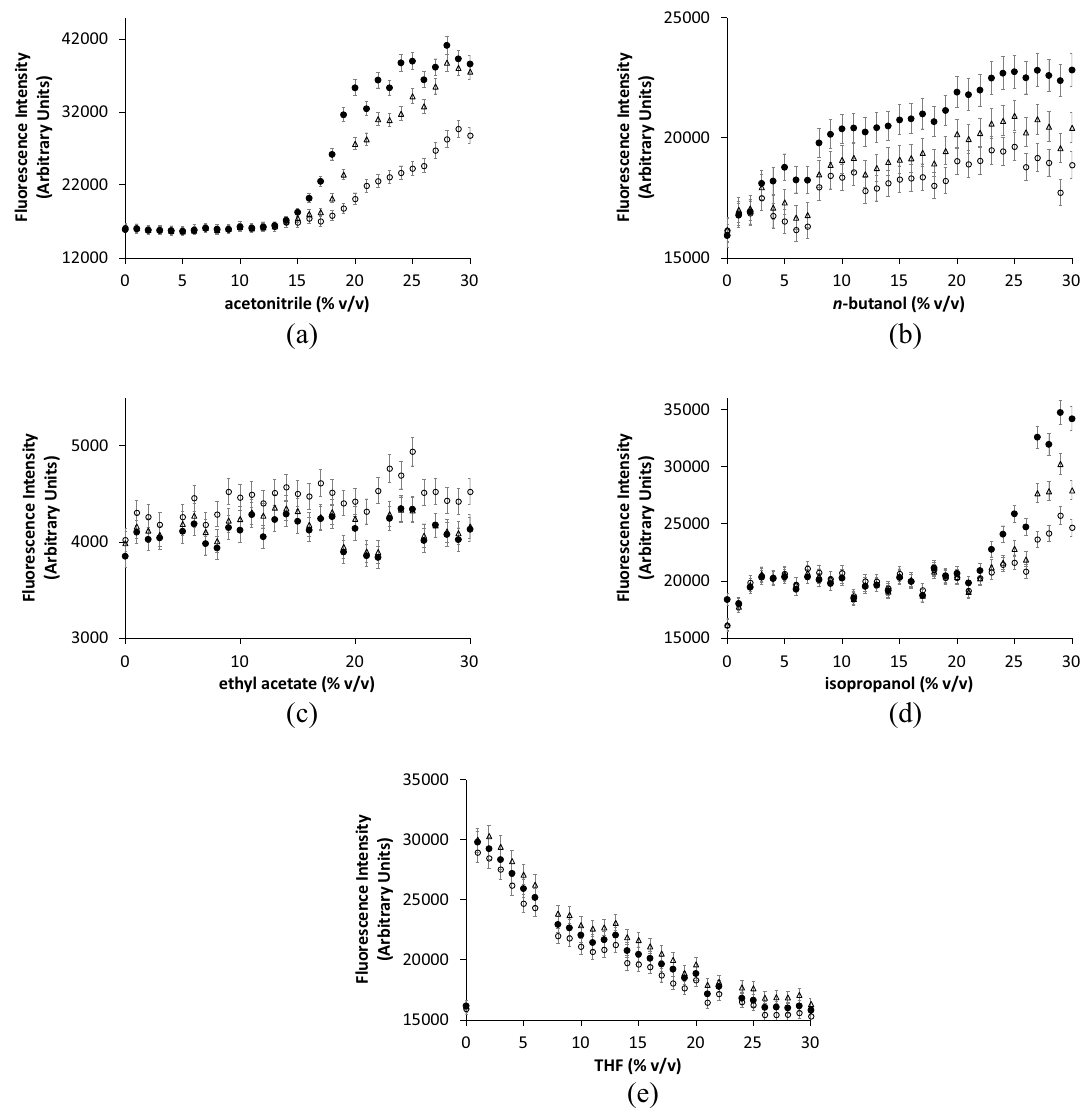
Figure 8. Fluorescence intensity measurements of apo-TK after incubation with increasing concentrations of organic solvents. Fluorescence intensity was measured at 340 nm with excitation at 280 nm. Apo-TK at 0.1 mg mL −1 in 25 mM Tris–HCl, pH 7.0 was incubated with ( a ) acetonitrile ( b ) n-butanol, ( c ) ethyl acetate ( d ) isopropanol ( e ) THF for (open circle) 1 h, (open triangle) 2 h, (filled circle) 3 h at 25 °C prior to measurements. Error bars represent one standard deviation about the mean (n =